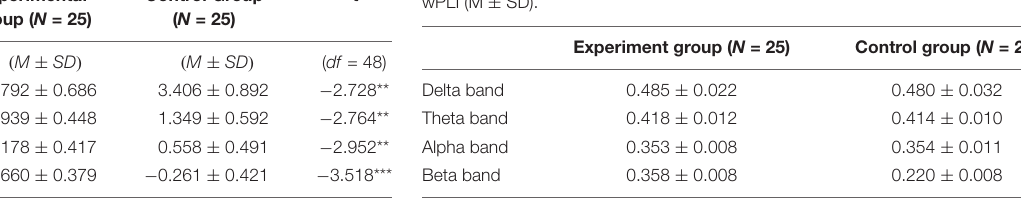
TABLE 3 | The differences between two groups in the whole-brain connectivity wPLI (M ±